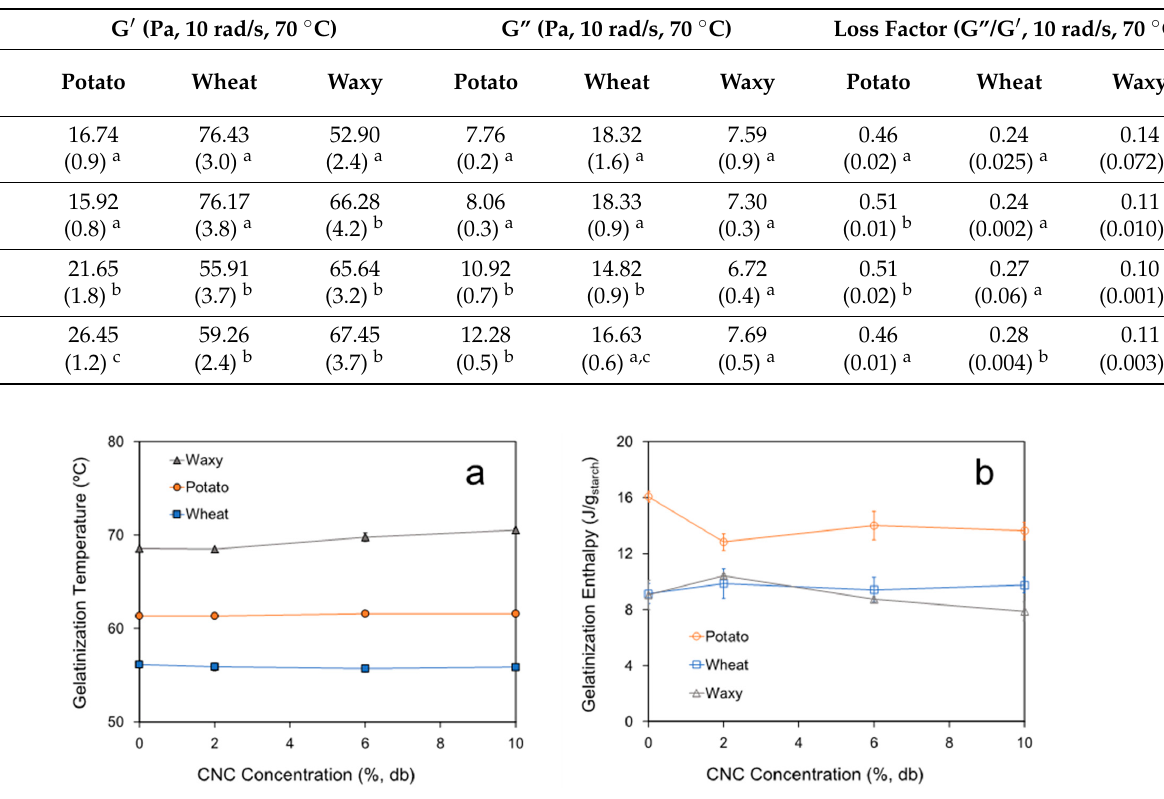
Figure 6. Gelatinization temperature ( a ) and enthalpy ( b ) of starch from different sources (potato, wheat and waxy) as a function of CNC concentration. Continuous lines only correspond to guide the eye.